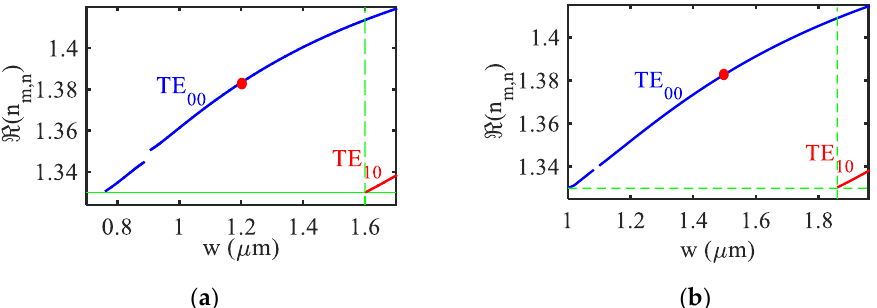
Figure 3. Variation of the real part of effective index of TE 00 mode and first higher-order mode TE 10 as a function of square waveguide’s width (w) for ( a ) HI-MCRW and ( b ) MCRW. The red dots represent the middle point of the single mode region.